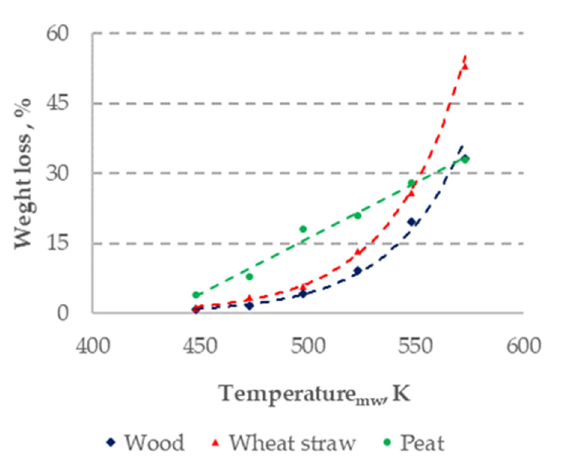
Figure 2. The weight loss of biomass pellets (on dry matter basis) as dependent on mw-assisted pretreatment temperature.